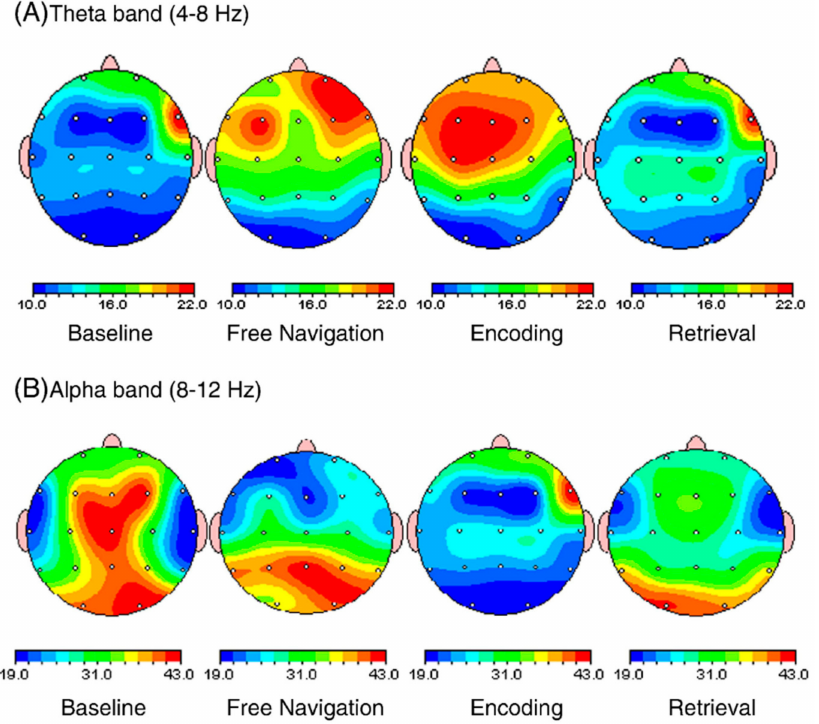
Figure 7. Brain maps showing topographical distribution of theta and alpha power during free navigation, baseline, encoding, and retrieval of visual–spatial working memory task. ( A ) brain map showing increase in theta power in right frontal and frontal central region during encoding and free navigation as compared to retrieval. When encoding is compared with baseline, the increase is again significant in right frontal brain region. Another point of interest is higher theta power at frontal central areas during free navigation as compared to retrieval. ( B ) brain map showing a significant increase in alpha power in all the regions during baseline in comparison to encoding and retrieval. When comparing encoding and retrieval, alpha power is slightly higher during retrieval at right parietal, left central and left, and right occipital brain regions. When comparing retrieval and free navigation, alpha power is reduced at occipital areas. Overall, both encoding and retrieval attenuate alpha power at all regions of interest (ROI). Adapted from brain research Jaiswal, N., Ray, W., and Slobounov, S. (2010). Encoding of visual–spatial information in working memory requires more cerebral efforts than retrieval: Evidence from an EEG and virtual reality study, 1347,